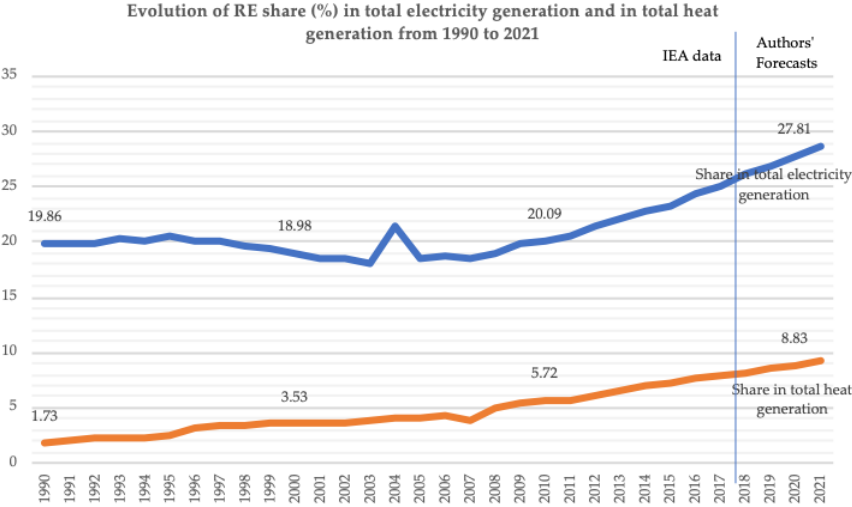
Figure 13. Evolution of RE share (%) in total electricity generation and in total heat generation from 1990 to 2021 (Source: IEA and authors’ forecasts).